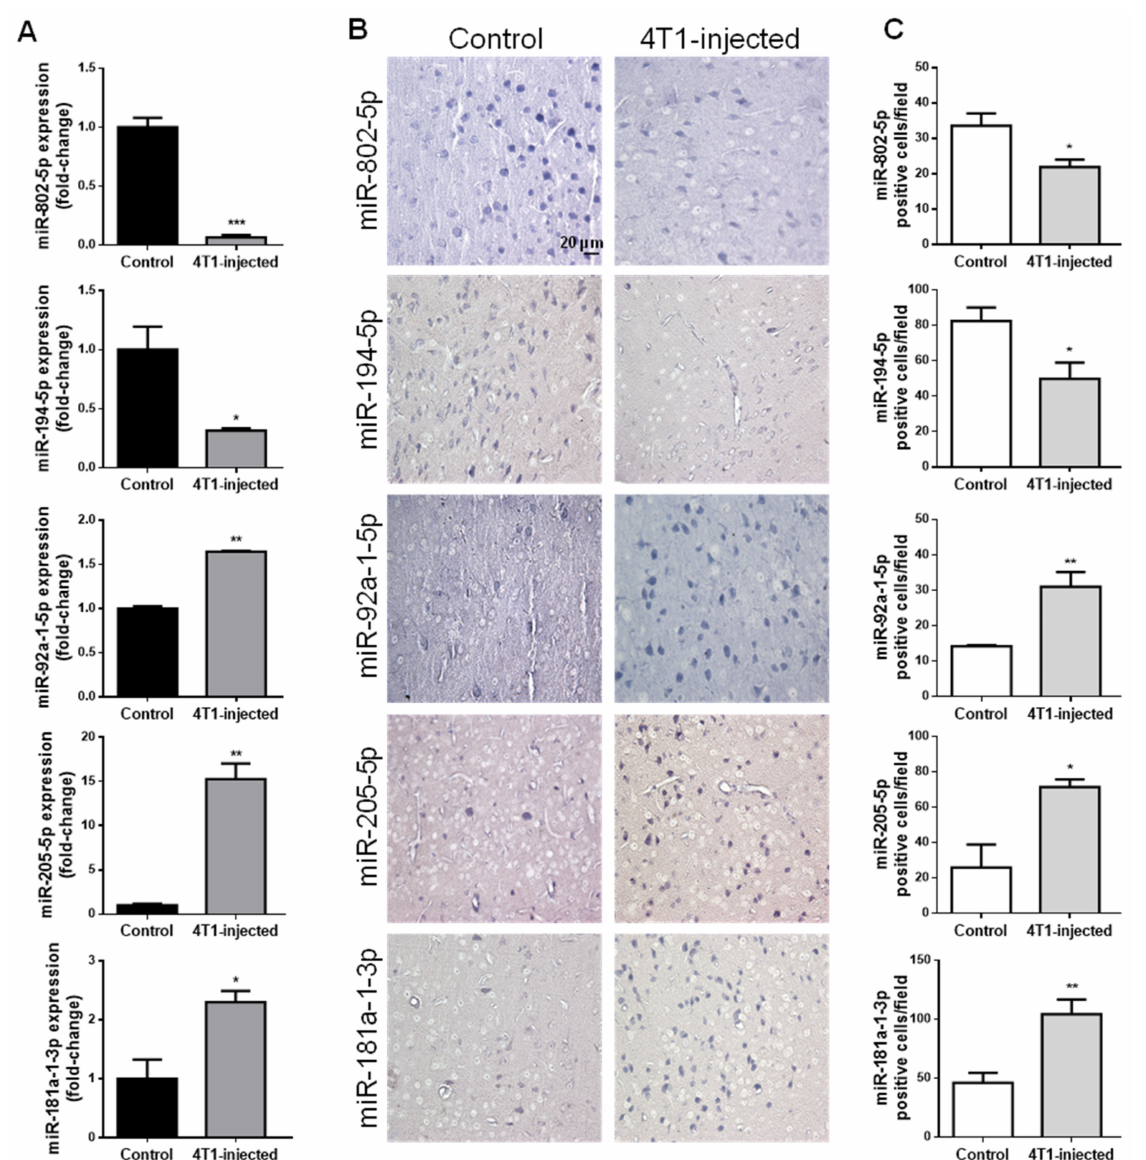
Figure 2. Circulating miRNAs alterations are related with their brain parenchyma deregulation in early stages of breast cancer brain metastases formation. 4T1 cells or vehicle (control) were inoculated into the carotid artery of female Balb/c mice and after 3 days, whole blood was collected, and brains harvested after sacrifice. Plasma was processed for real-time quantitative PCR (RT-qPCR) and sections of cranial hippocampus were processed for in situ hybridization (ISH) analysis of the different miRNAs. RT-qPCR analysis highlighted the downregulation of miR-802-5p and miR-194-5p, and the up-regulation of miR-92a-1-5p, miR-205-5p and miR-181a-1-3p in 4T1-injected mouse plasma, with the results presented as fold-change vs. control ( A ). ISH analysis validated the same miRNAs downregulation and upregulation, as shown by the expression of these miRNAs in bluish stained brain cells ( B ), and ascertained by semi-quantitative analysis of the number of each miRNA positive cell per field ( C ). Statistical differences are denoted as * p < 0.05, ** p < 0.01, *** p < 0.001 vs. control by two-tailed unpaired Student’s t -test. Data represented are means ± SEM, n =